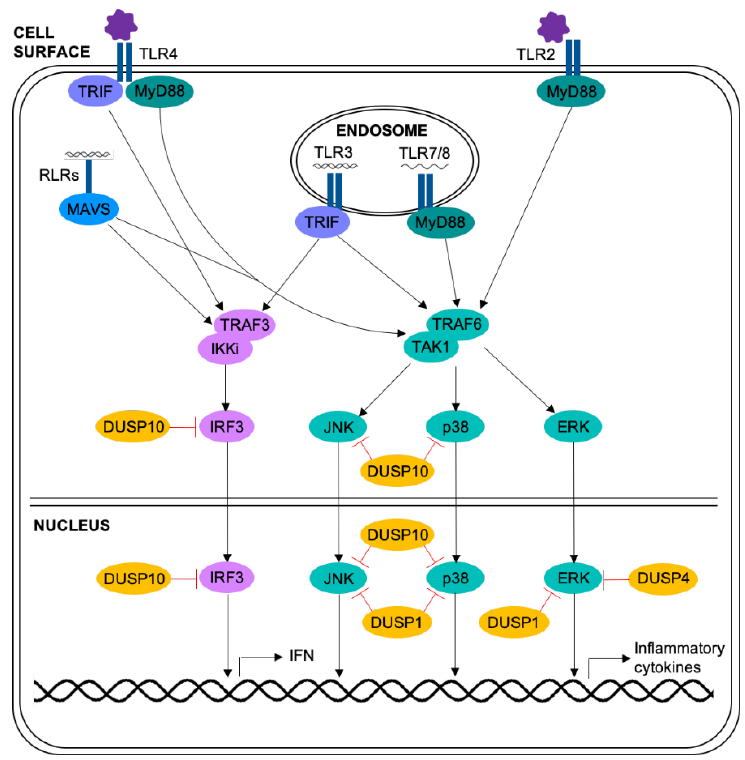
Figure 2. Regulation of the MAPK pathways by DUSPs in epithelial cells upon viral infection. PRR recognition of viruses or viral components activates the MAPK and IRF3 pathways. The MAPKs and IRF3 translocate to the nucleus and induce expression of inflammatory cytokines and interferon. These pathways are negatively regulated (red arrows) through dephosphorylation by DUSPs. DUSP1 is present in the nucleus and dephosphorylates all three MAPKs. DUSP4 is a nuclear protein, and is thought to dephosphorylate ERK. DUSP10 is present in both the nucleus and the cytoplasm and dephosphorylates JNK, p38 and IRF3. Black arrows represent activating interactions, red arrows represent inhibition.